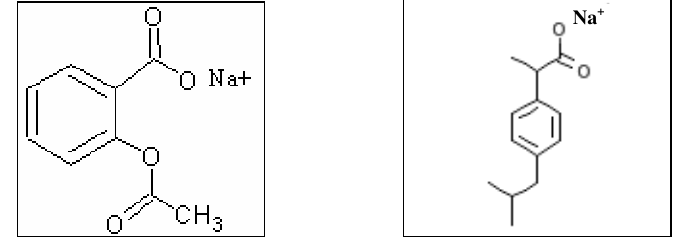
Figure 1 . Structural formulae of the sodium salts of acetylsalicylic acid and